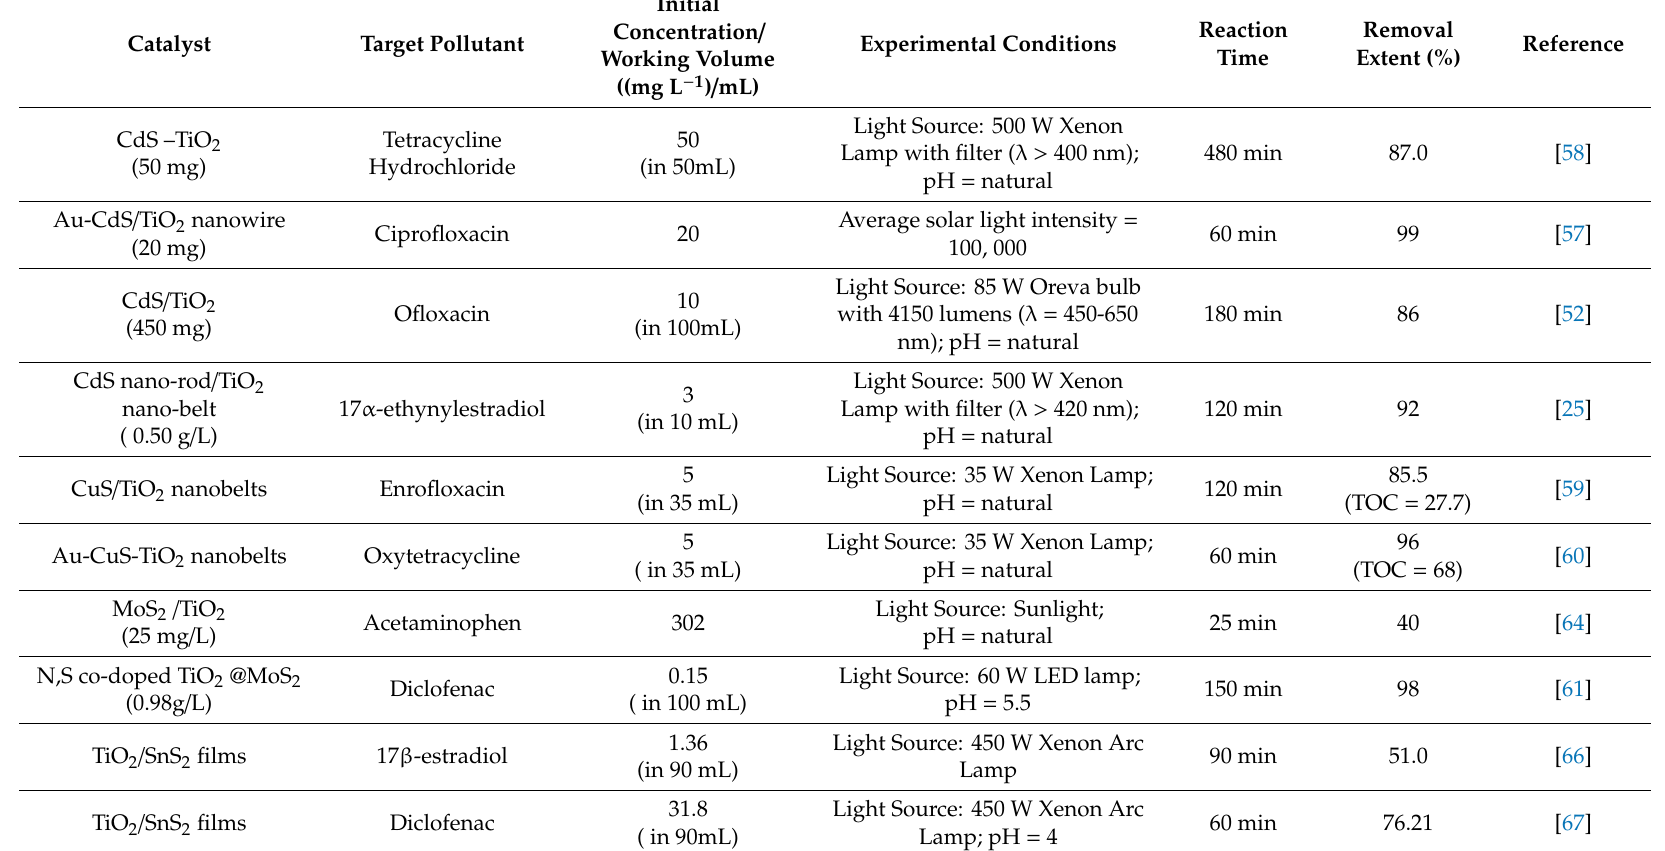
Table 6. Photocatalytic degradation of CEC’s over TiO 2 / Metal sulfide